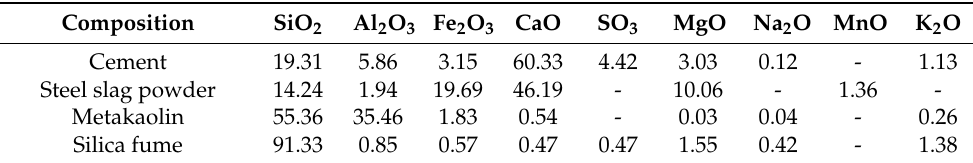
Table 2. Main chemical compositions of materials (wt %).